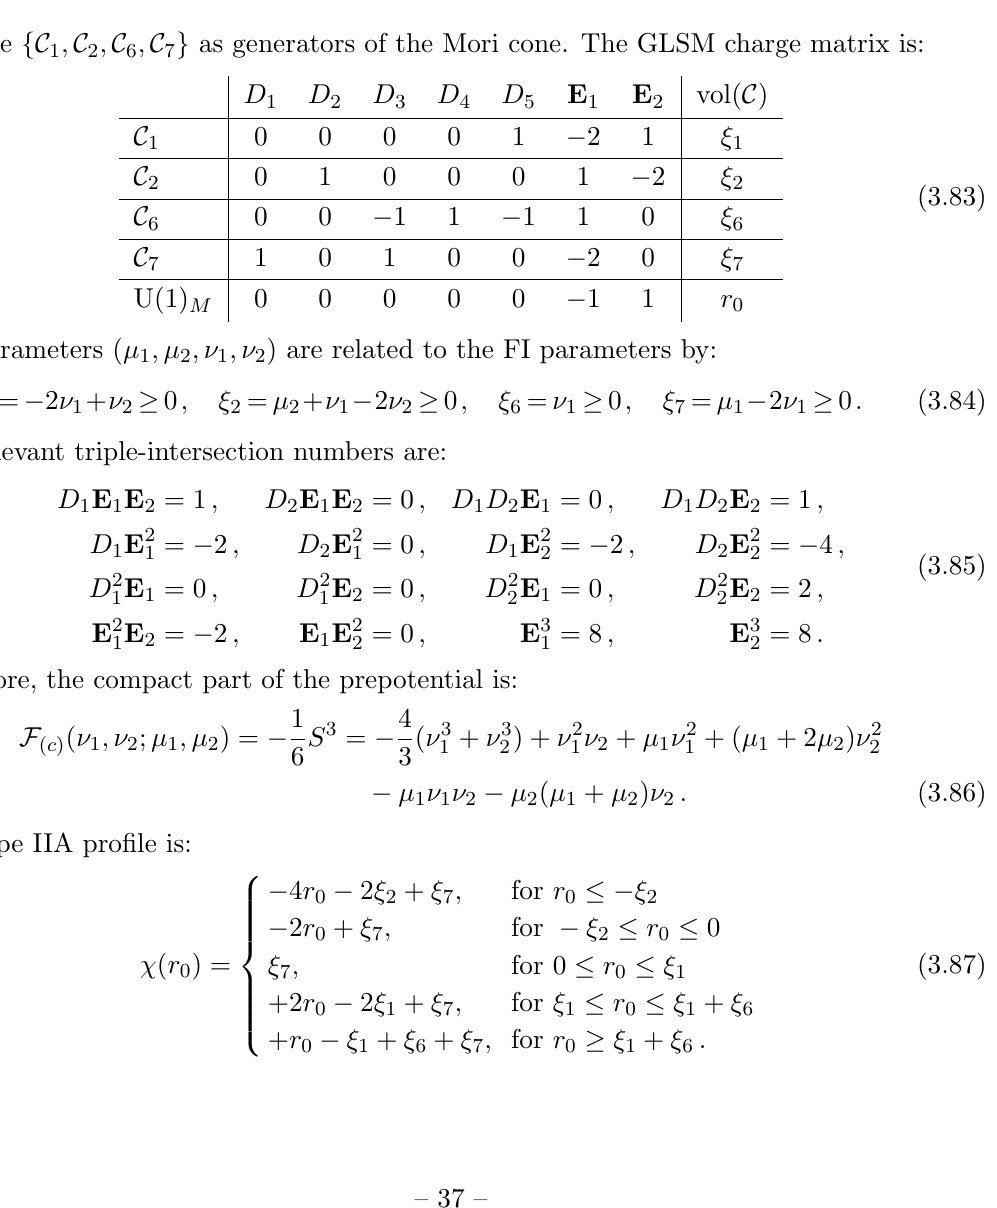
Figure 14 . Resolution (c) of the E 22 ; 3 2 singularity and its vertical